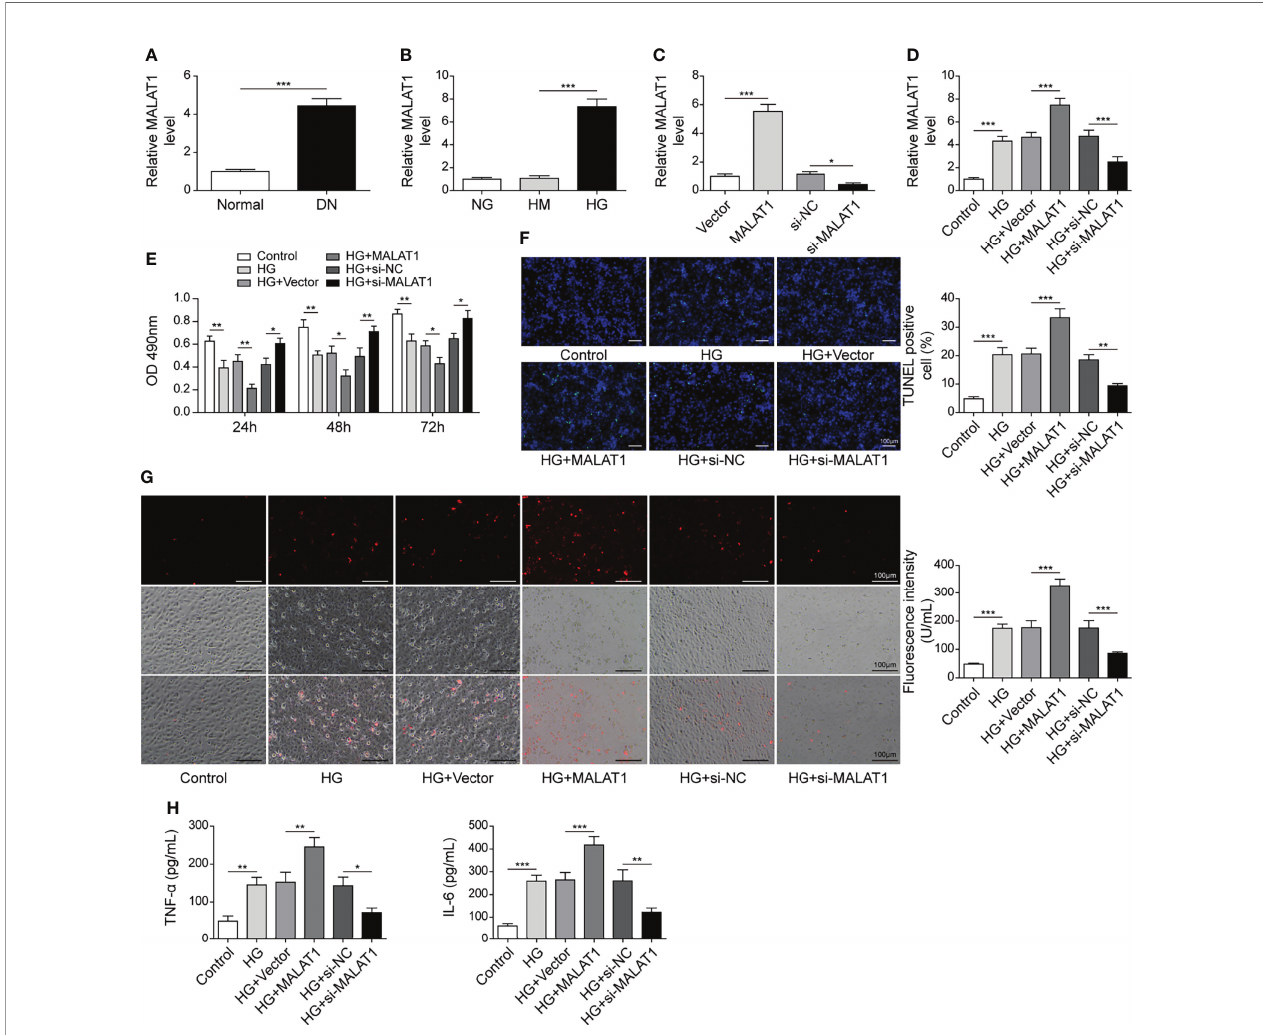
FIGURE 1 | MALAT1 aggravated HG-induced injury in HK-2 cells. (A) qRT-PCR analysis of MALAT1 in DN and normal tissues (n=6). (B) qRT-PCR analysis of MALAT1 in HK-2 cells with NG, HM or HG (n=4). (C) The expression of MALAT1 was validated using qRT-PCR (n=4). HK-2 cells were transfected with vector, oe- MALAT1, si-NC or si-MALAT1 and subsequently treated with HG for 48 h (D) qRT-PCR analysis of MALAT1 (n=4). (E) Cell viability was examined by MTT assays (n=4). (F) TUNEL staining (TUNEL, green. Scale bar=100 µM) were examined. (G) Cellular ROS levels were examined by a fl uorometric ROS sensor (red, n=4). (H) Secretion of TNF- a and IL-6 into culture supernatants (n=4). * P < 0.05, ** P < 0.01 and *** P <